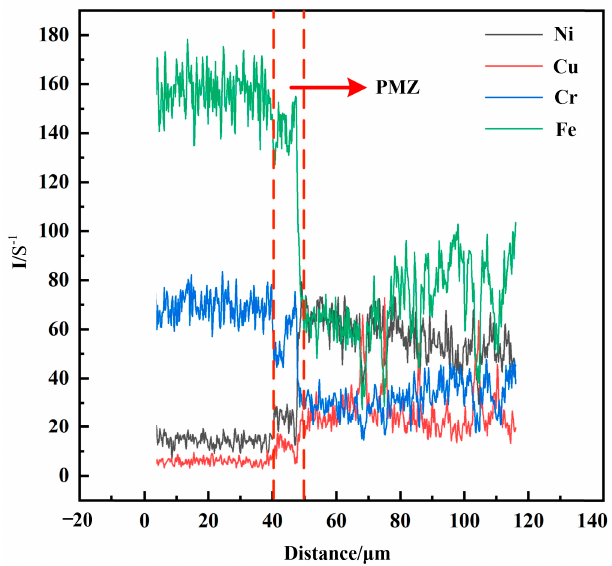
Figure 7. EDS cure of SS/weld interface in joint 2.